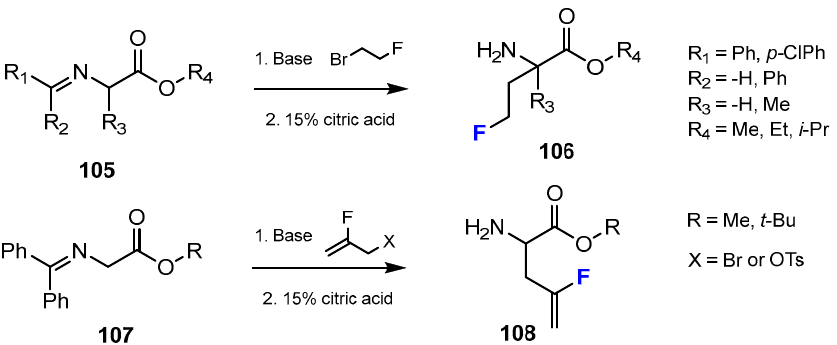
Figure 2. Chemical structure of largazole. The fluorine-containing side chain fragments were provided via several types of re- actions, which are all described in Scheme 29 below. The first step to introduce the fluorine for the design of cyclic peptides was the alkylation with ethyl 2-bromo-2,2-difluoroacetate in the presence of triphenylphosphine and diethylzinc in THF. An alternative method for fluorination was through a Reformatsky reaction with ethyl 2-bromo-2,2-difluoroacetate, zinc in THF. Another pathway involved a two-step process. The first step was the prepa- ration of 1-alkynyl(phenyl)iodonium tetrafluoroborate from alkyne. Then, the intermedi- ate was fluorinated by the reaction with 20% HF aqueous solution in CHCl 3 . Moreover, the use of starting materials that already contain the fluorine substituent is also feasible.